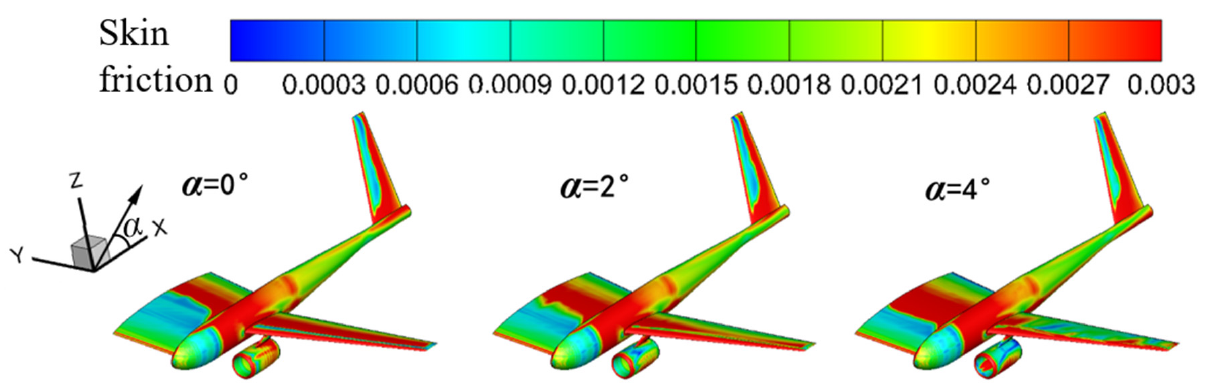
Figure 20. Skin friction coefficient contour of the whole aircraft with different α .